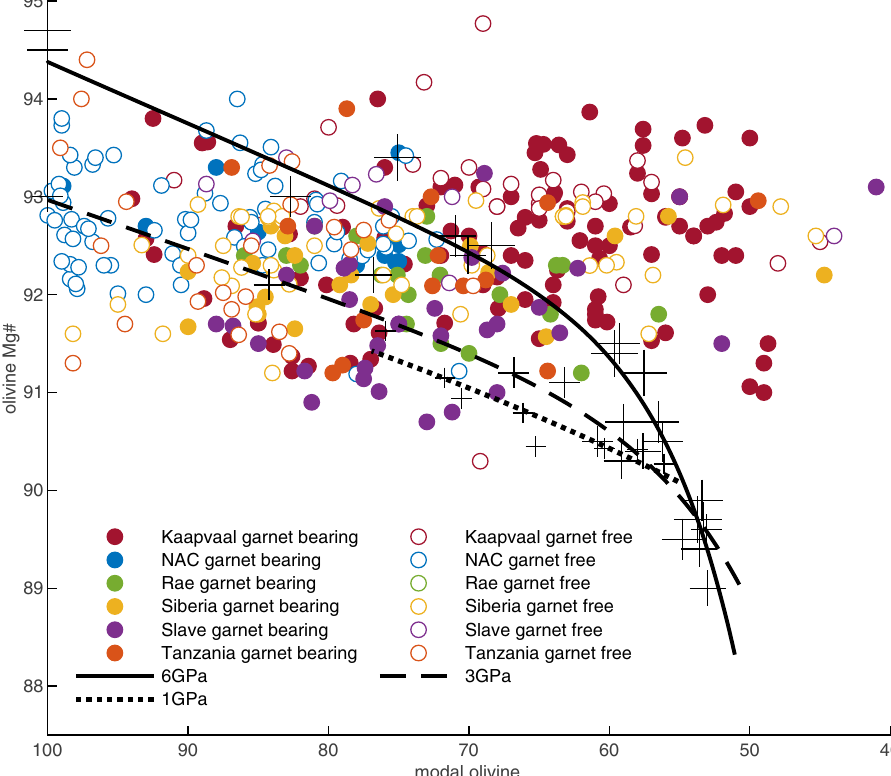
Fig. 1 Modal olivine ‘ vs ’ olivine forsterite content for peridotites from the six studied cratons. Also shown are the compositions ( + symbols, size scaled for pressure) and fi tted trends for the evolution of experimental residues after melting of fertile peridotite at 1 GPa 43 , 3 GPa and 6 GPa 41